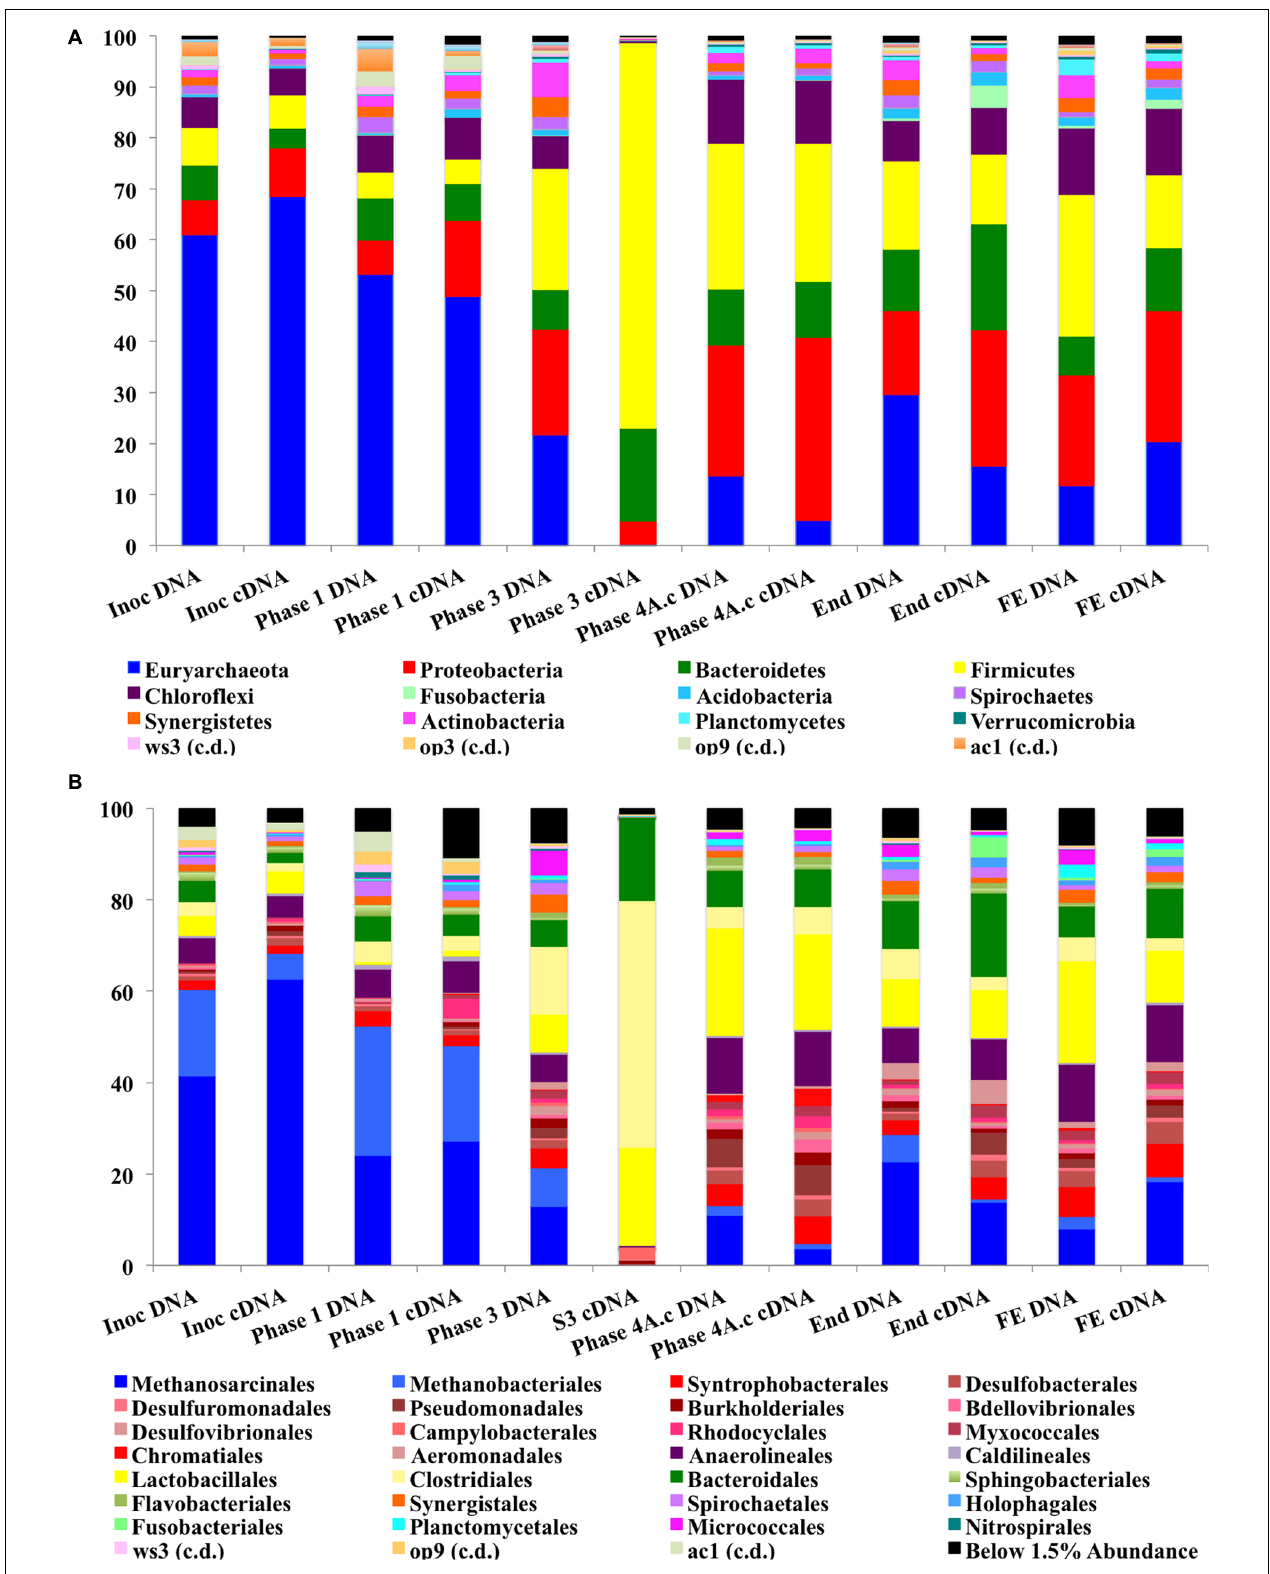
FIGURE 5 | (A) Stacked bar charts for phylum-level Illumina MiSeq analysis. (B) Stacked bar charts for order-level Illumina MiSeq analysis.